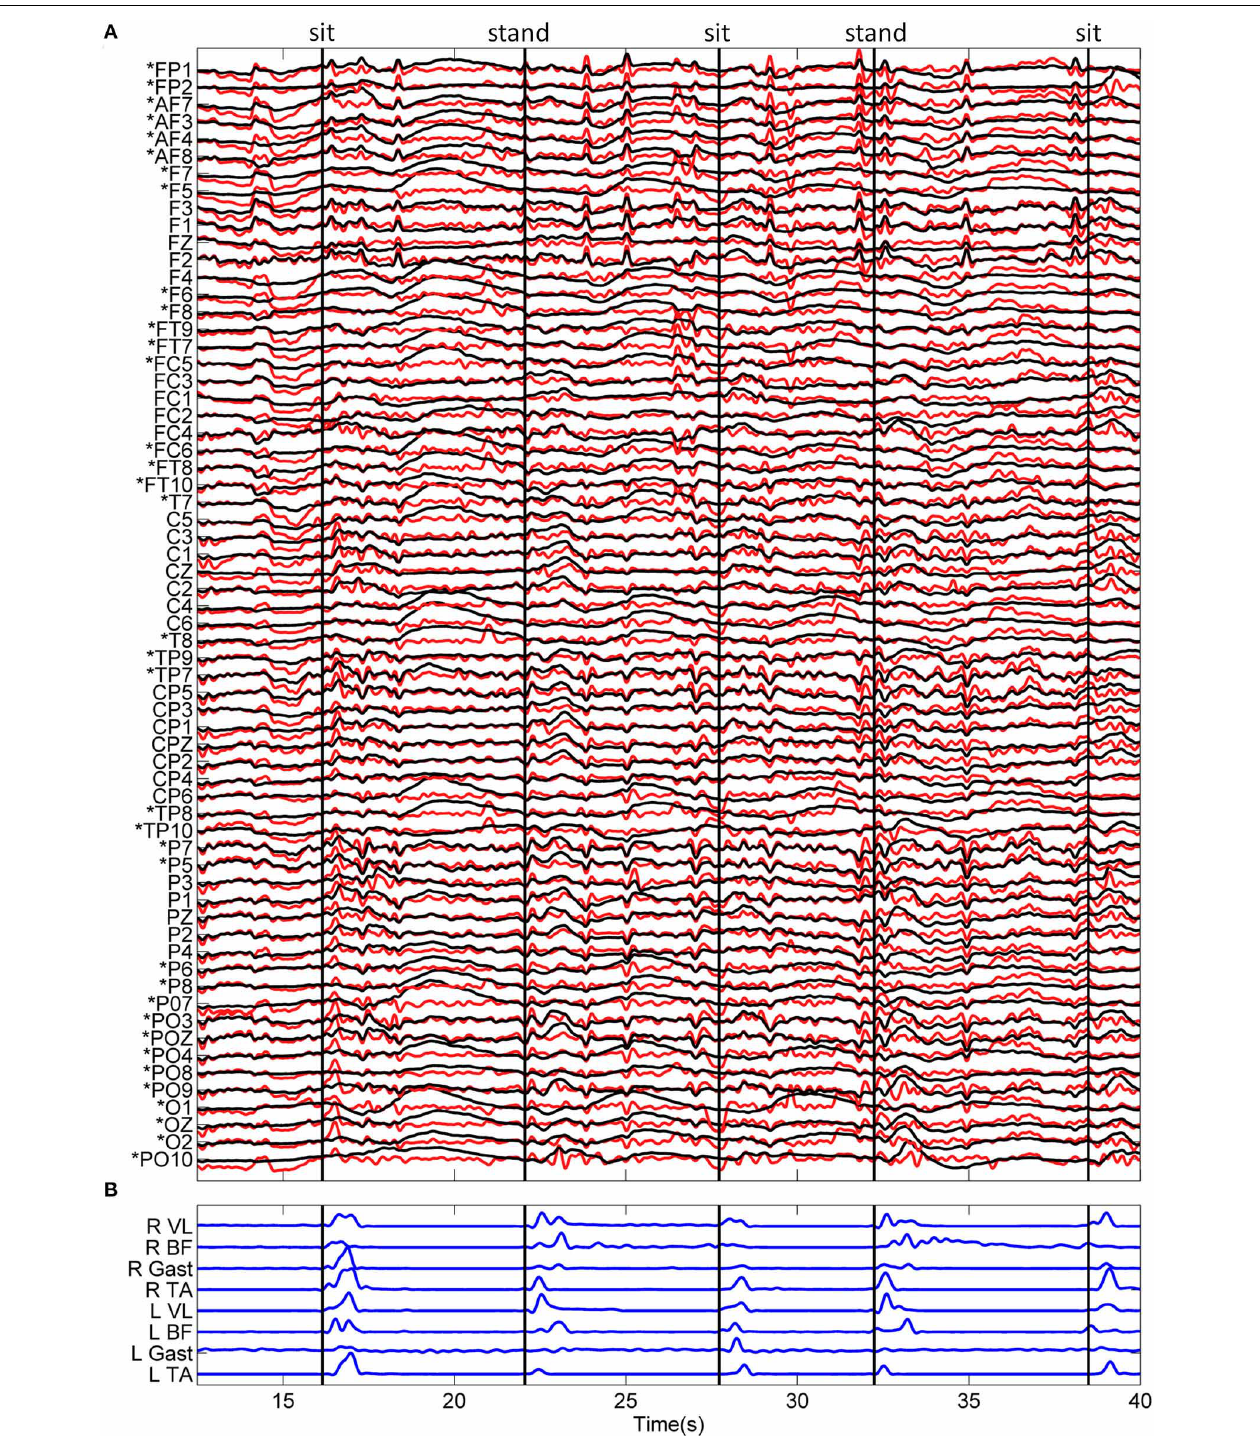
FIGURE 2 | Typical recordings of EEG and EMG data during the sitting and standing task. (A) Standardized (z-score) EEG data is shown before (black) and after (red) ASR algorithm for artifact rejection. An asterisk ( ∗ ) indicates peripheral channels